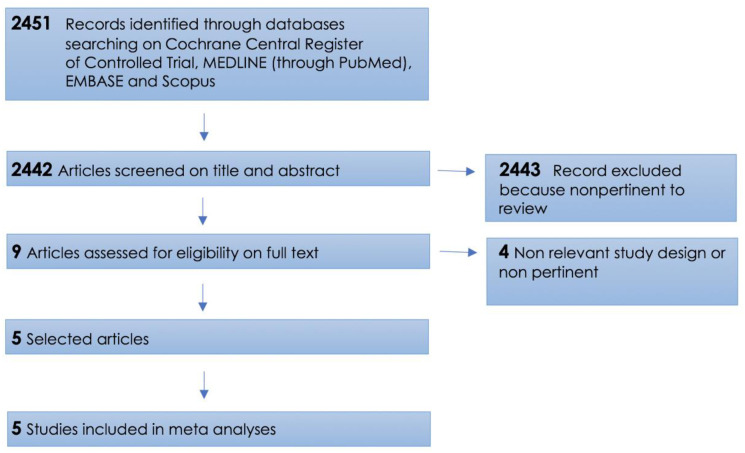
A PRISMA flow diagram of the inclusion of studies.